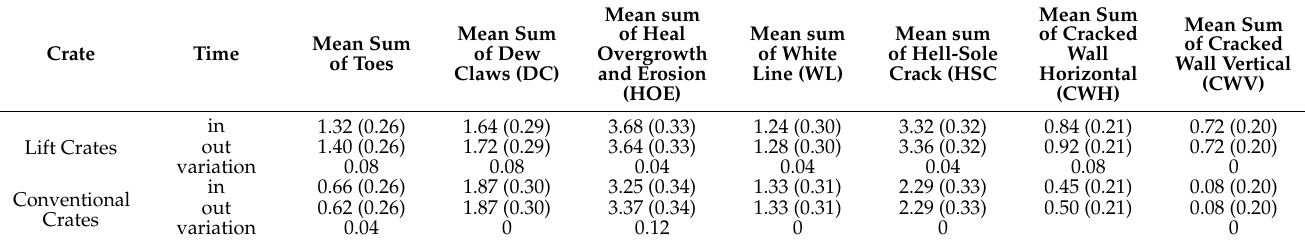
Table 7. Mean values of locomotion and feet disease